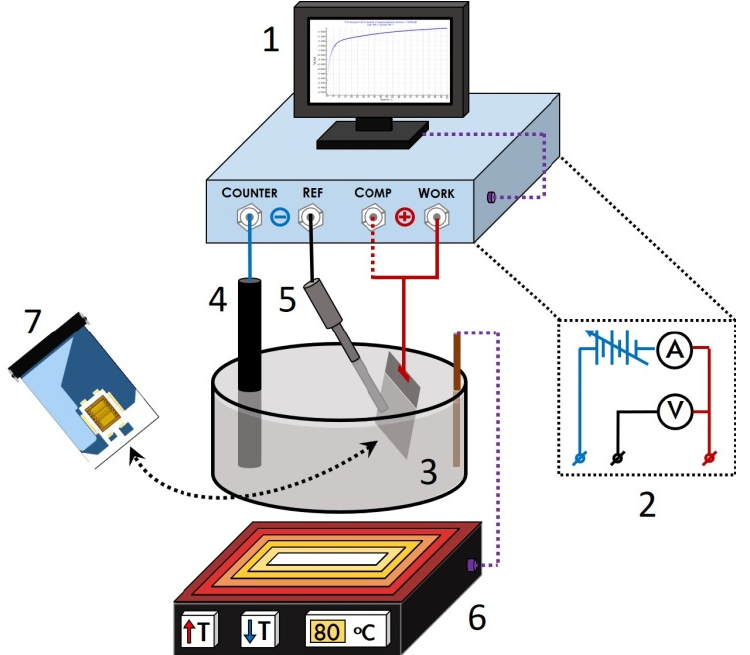
Figure 1. The scheme for deposition of ZnO nanostructured layer over multi-electrode chip employing a three-electrode electrochemical cell: 1—a potentiostat interfaced with PC, 2—a simplified circuit diagram of electric potential application by the potentiostat, 3—electrolyte, 0.1 M Zn(NO 3 ) 2 , 4—graphite rod, 5—Ag/AgCl sat electrode, 6—a hotplate, 7—a multi-electrode chip wired in a ceramic holder.